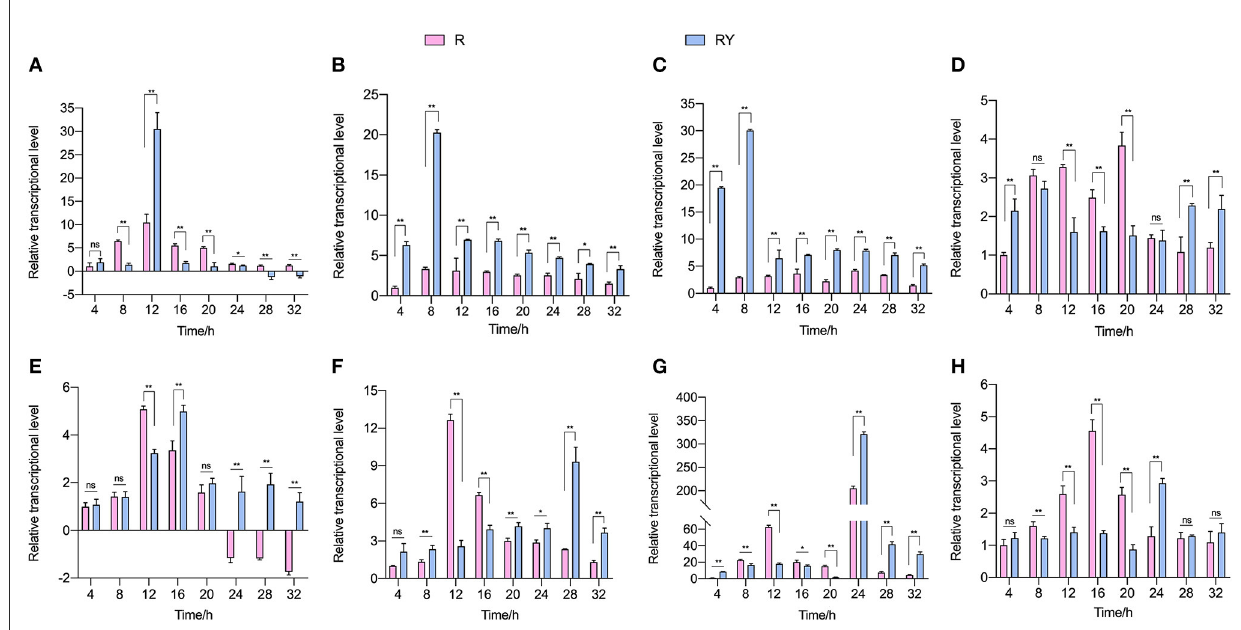
FIGURE2 Transcriptional level of plantaricin biosynthesis ( plnABCDEF ; A–F ) and AI-2 synthesis-related gene ( pfs and luxS ; G, H ). R means mono-culture of L. paraplantarum RX-8 at 37 ◦ C in 4–32h, and RY means bacteriocin-inducing co-culture of L. paraplantarum RX-8 and W. anomalus Y-5 at 37 ◦ C in 4–32h. ns, not significant, * p < 0.05, ** p <